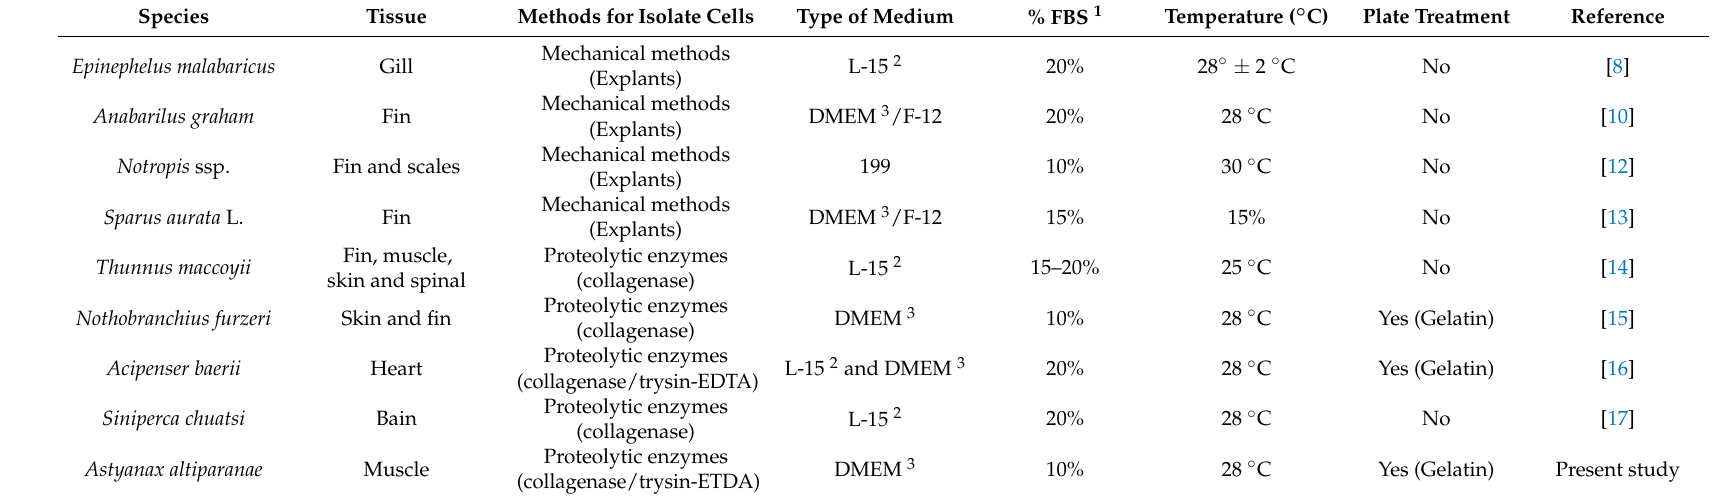
Table 1. Main techniques used for fish cell cultures and their conditions of